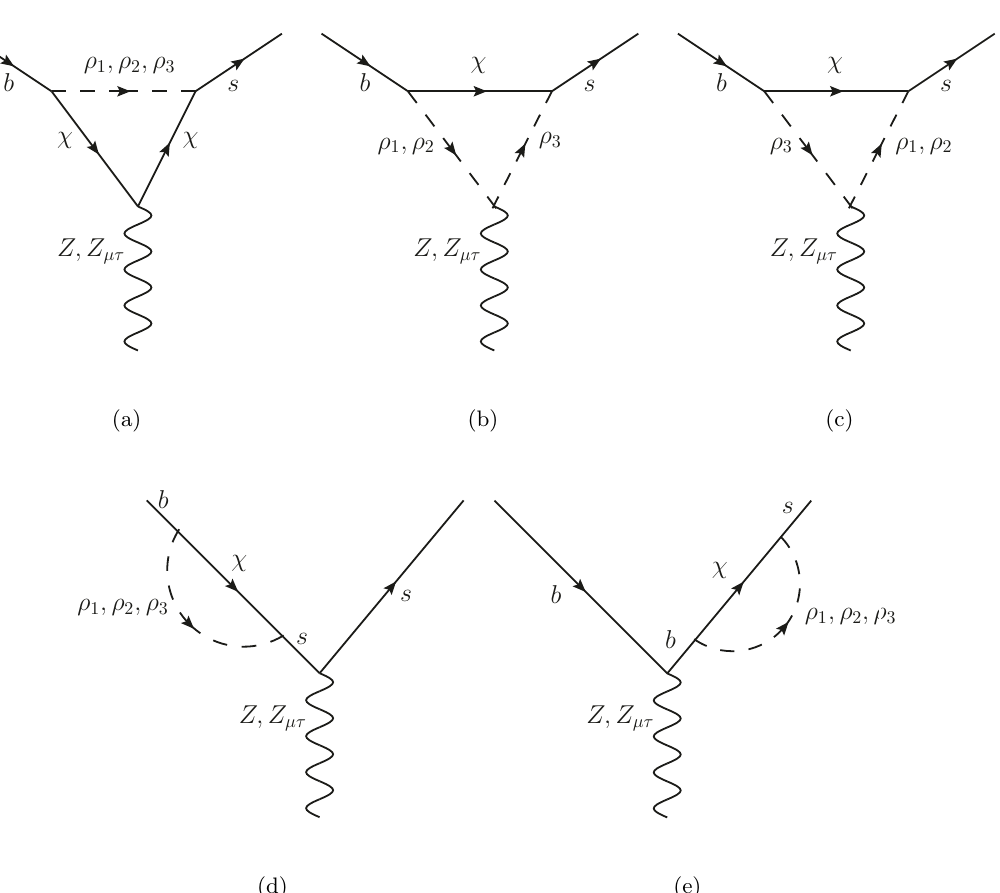
s(cid:22)(cid:22) !